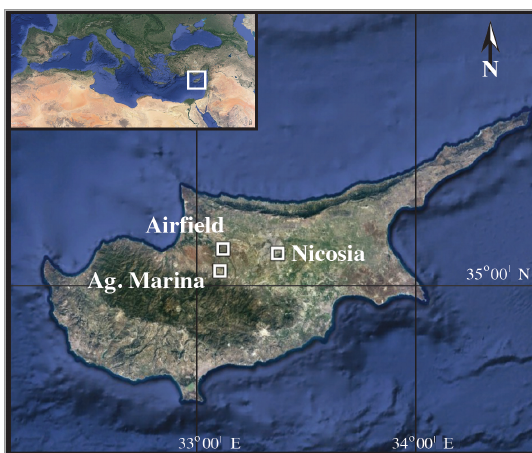
Figure 1. Map of Cyprus showing the locations of the observa- tion sites used for the measurements reported in this paper. The inset in the upper-left corner shows the greater area of southern Eu- rope, northern Africa and the Middle East, with the white square indicating the location of Cyprus. The maps were generated by Google Earth Pro (https://www.google.com/earth/download/gep/ agree.html, last access: 6 April 2017).